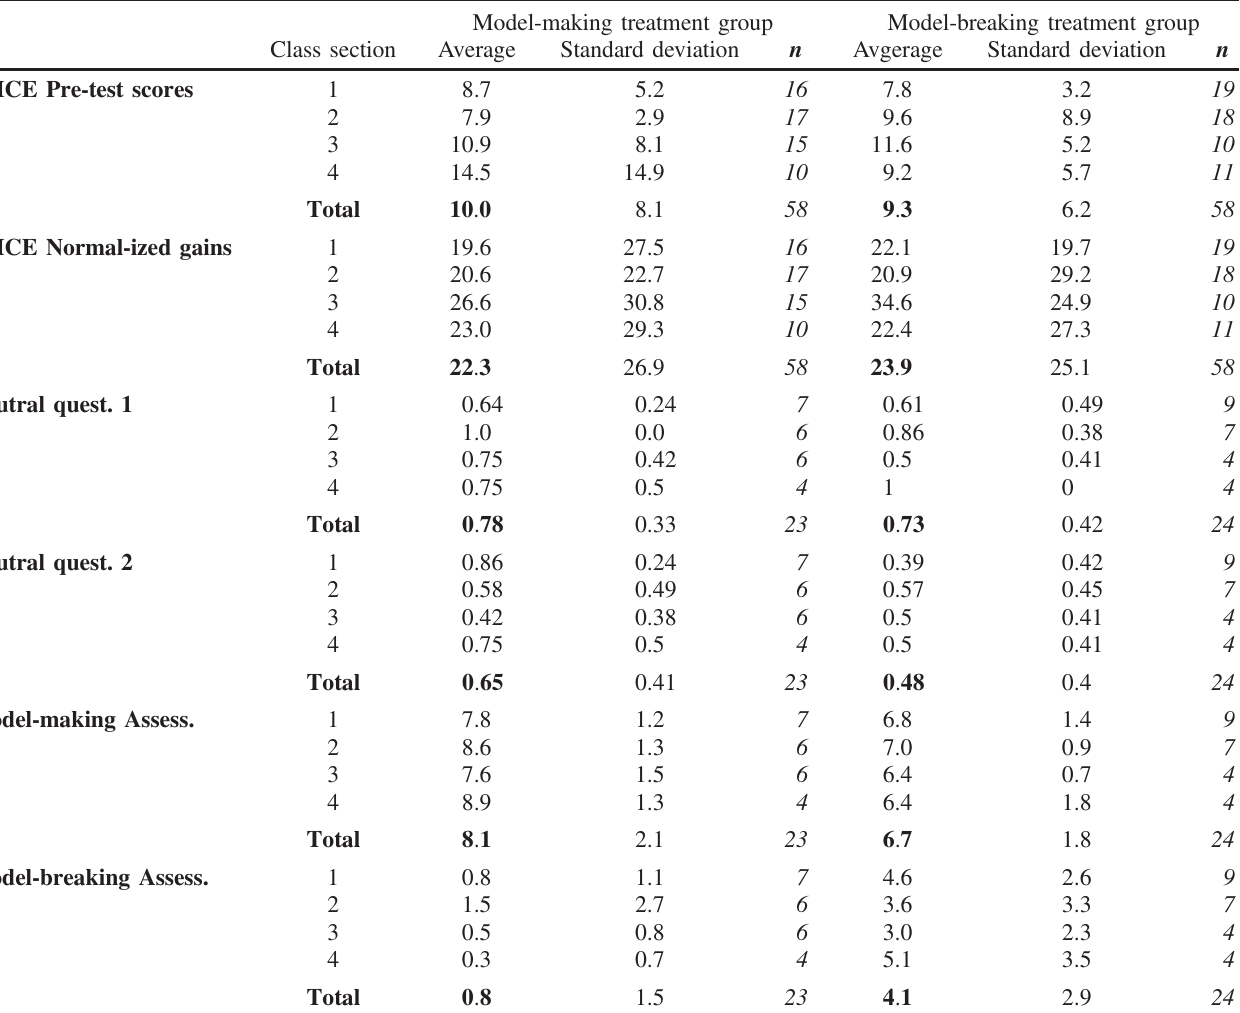
TABLE I. Detailed information about the performance of each treatment group within each class section on each of six measures. Please note that because many of the data sets were not normal all of the statistical comparisons in this study used the nonparametric Mann-Whitney U test, which is based on median values, and not mean values. The sample size, n , reflects either individuals (FMCE data) or small lab groups (non-FMCE